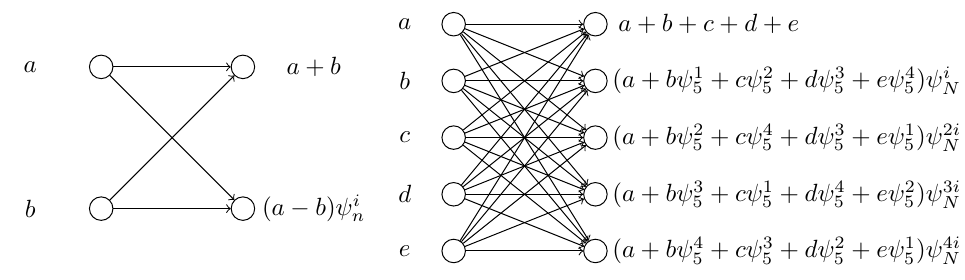
Figure 4: Radix-2 and radix-5 Gentleman-Sande butterfly